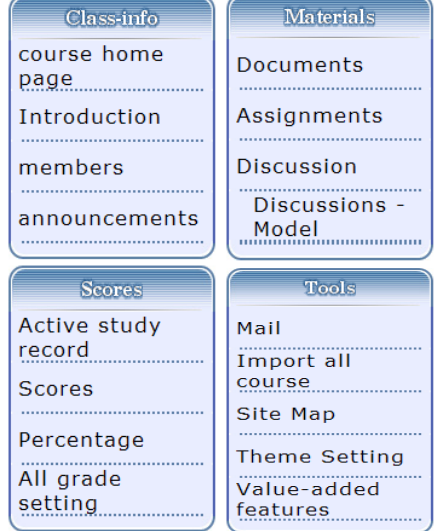
Figure 2. Control panels of each